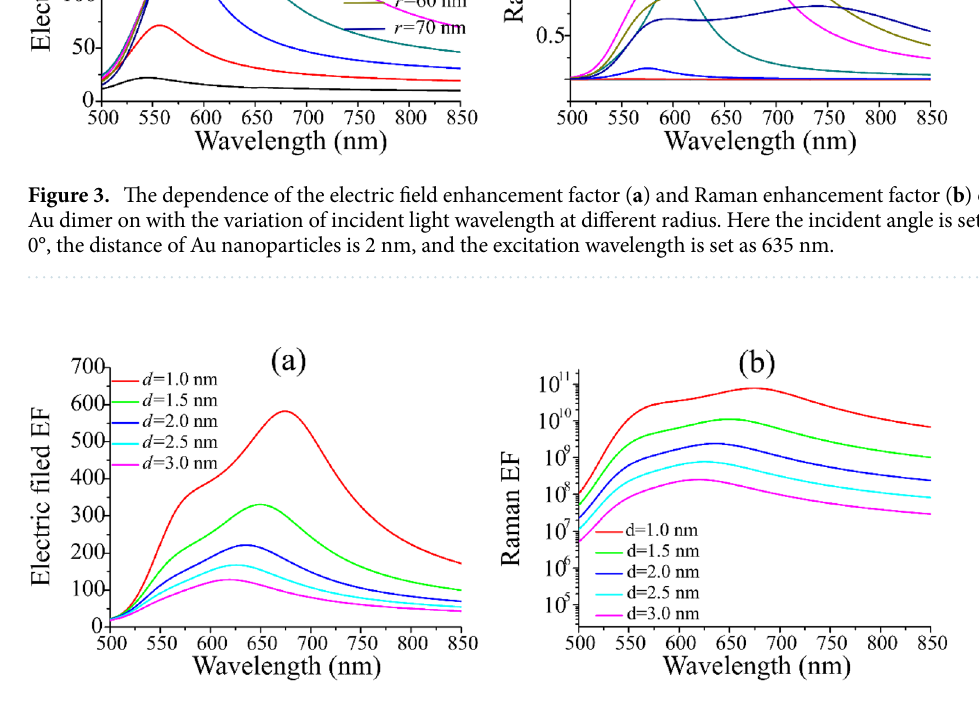
Figure 4. The relation curves of electric field intensity enhancement factor ( a ) and Raman enhancement factor ( b ) with the variation of incident light wavelength at different distance between Au dimers. The incident angle is 0°, the radius of Au nanospheres particle is 50 nm, and the excitation wavelength of Raman enhancement factor is 635